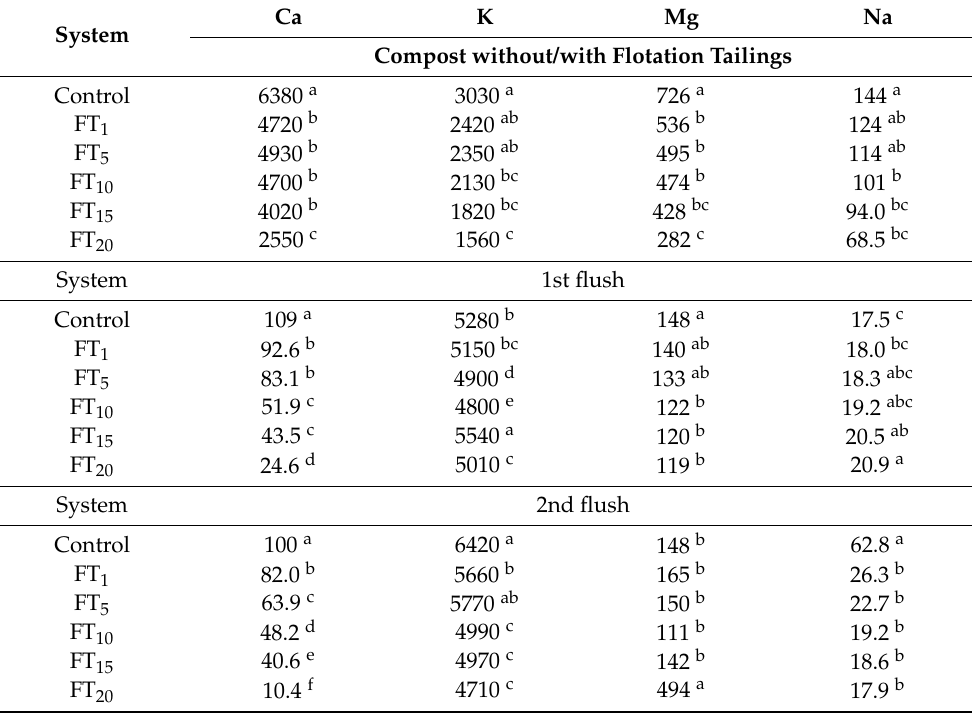
Table 2. Content of major essential elements [mg kg − 1 dry weight] in compost with flotation tailings before the experiment and fruit bodies from particular flushes.